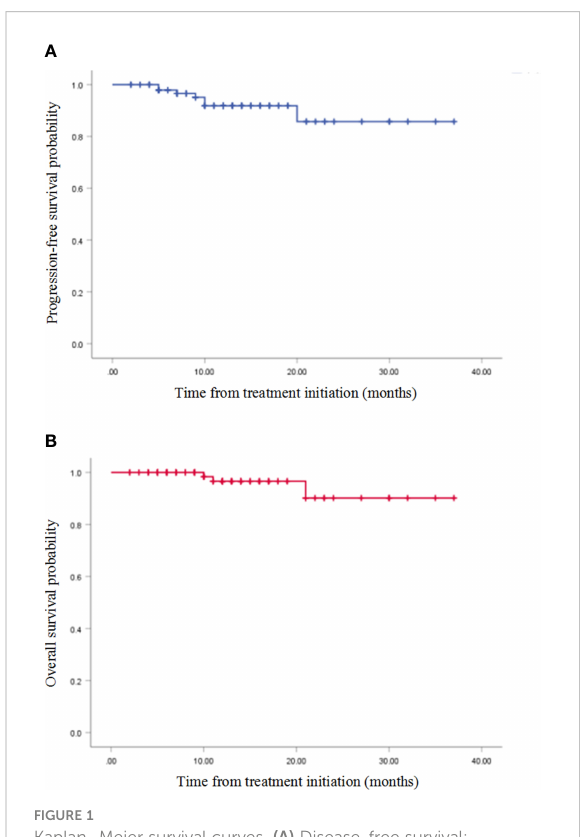
FIGURE 1 Kaplan – Meier survival curves. (A) Disease-free survival; (B) overall